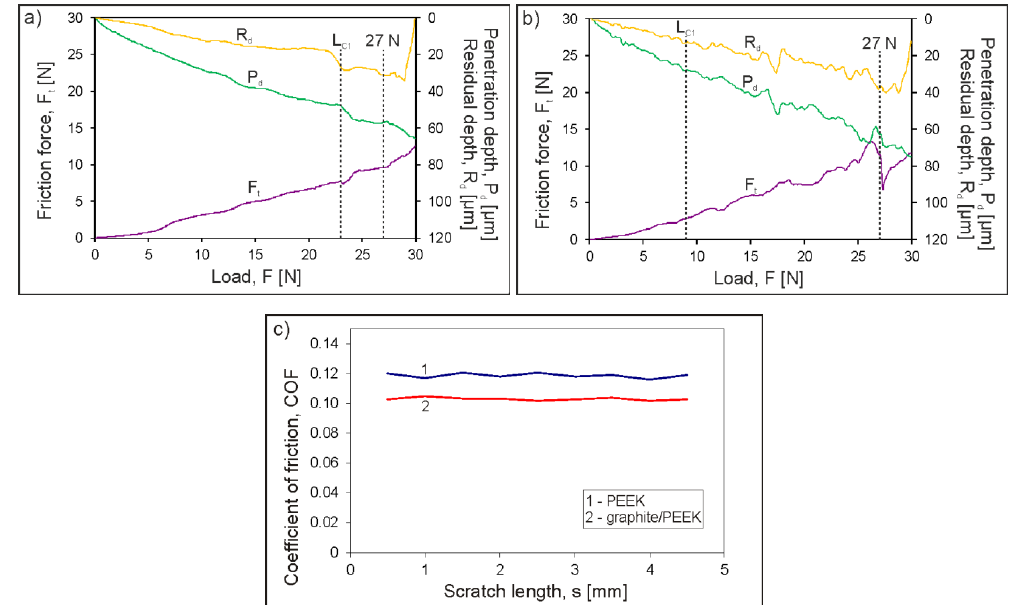
Figure 9. The scratch test results (friction force, penetration depth and residual depth signals) of PEEK coating ( a ), and graphite/PEEK coating ( b ), and friction coefficient of the coatings vs. diamond stylus in a scratch test at 0.25 N constant load ( c ).